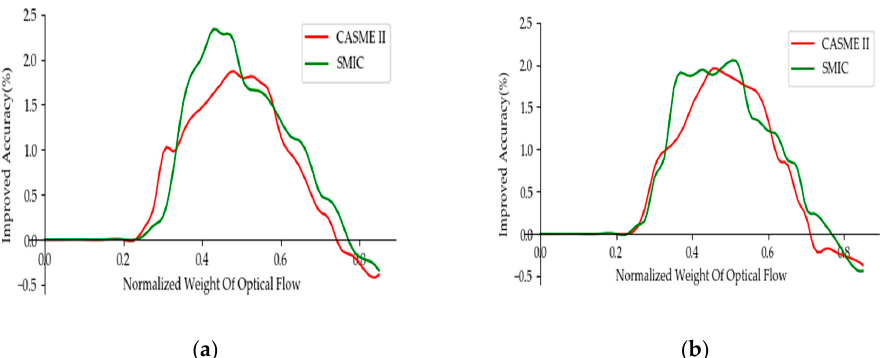
Figure 4. The sensitivity of OFF2BD with various thresholds δ . ( a ) Represents the train-set; ( b ) represent the test-set.